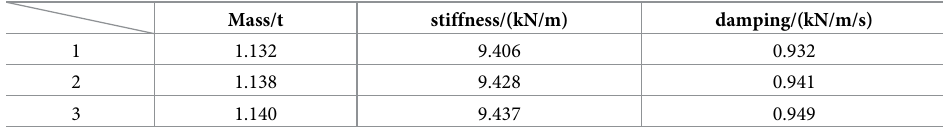
Table 6. Identification results of the shaking table array.